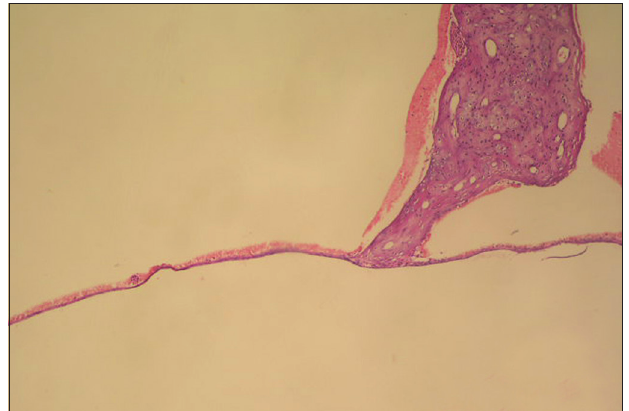
Figure 1. Appearence of normal tympanic membrane (0 point scale) in group A (hematoxylin and eosin, original magnification